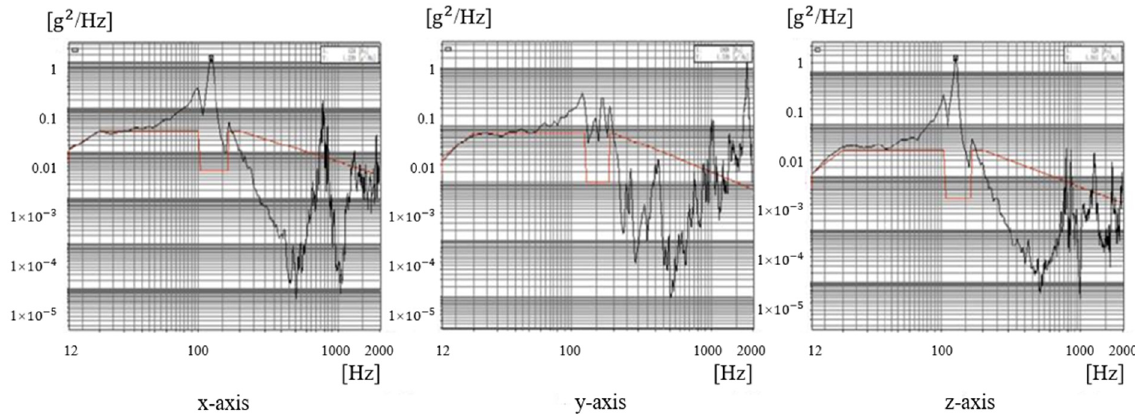
Figure 20. Stress response of random vibration at sampling points.